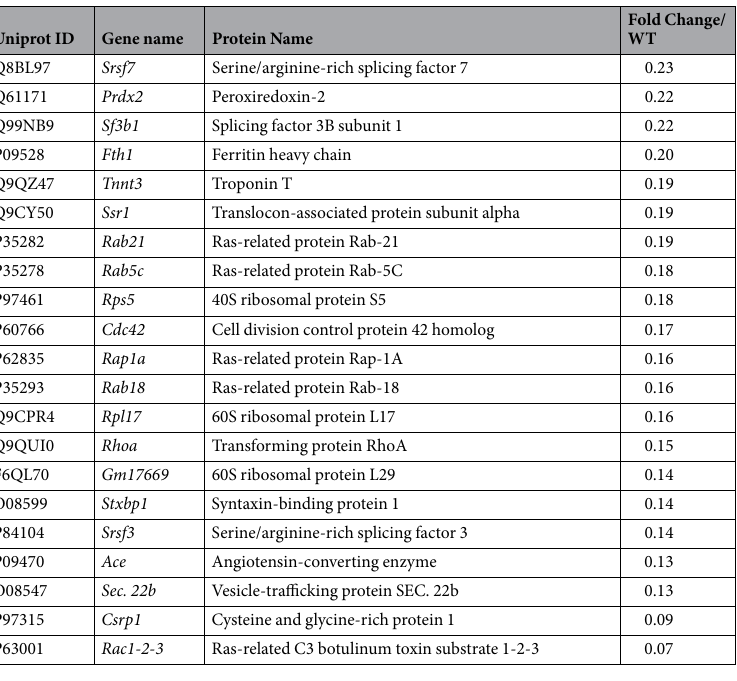
Table 1. Variation in Protein Levels in TG eyecups at one month. Threshold is set at 3-fold change.